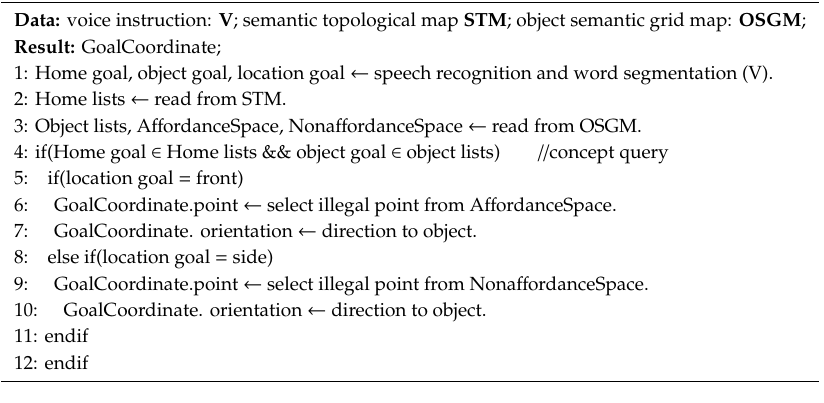
Algorithm A1: Automatic selection of navigation goal